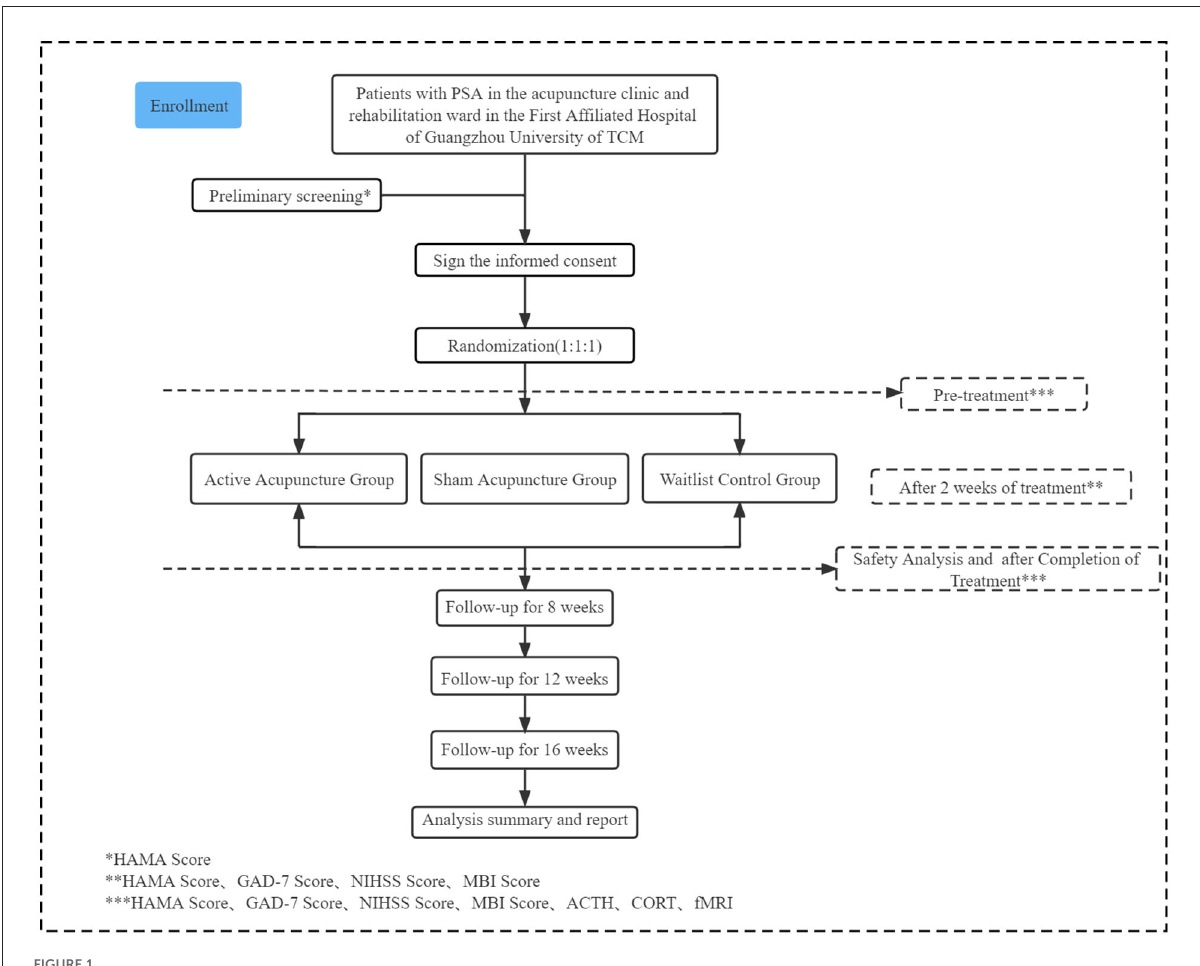
FIGURE1 Flow diagram of the study